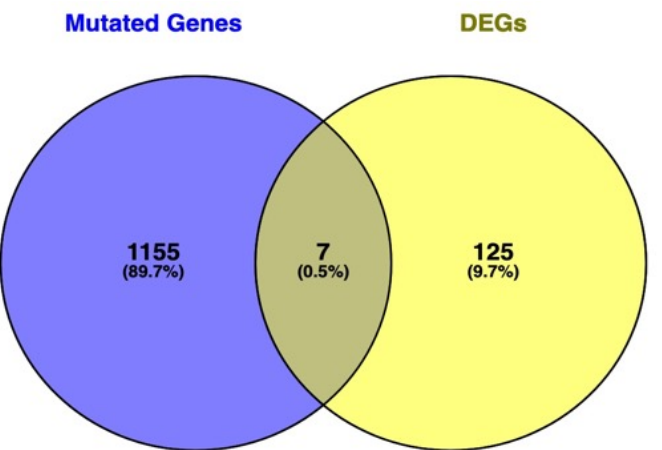
Figure 8. Venn diagram showing the intersection level between the list of genes found to be significant in both approaches: WES mutated genes and differentially expressed genes (DEGs). Genes at the